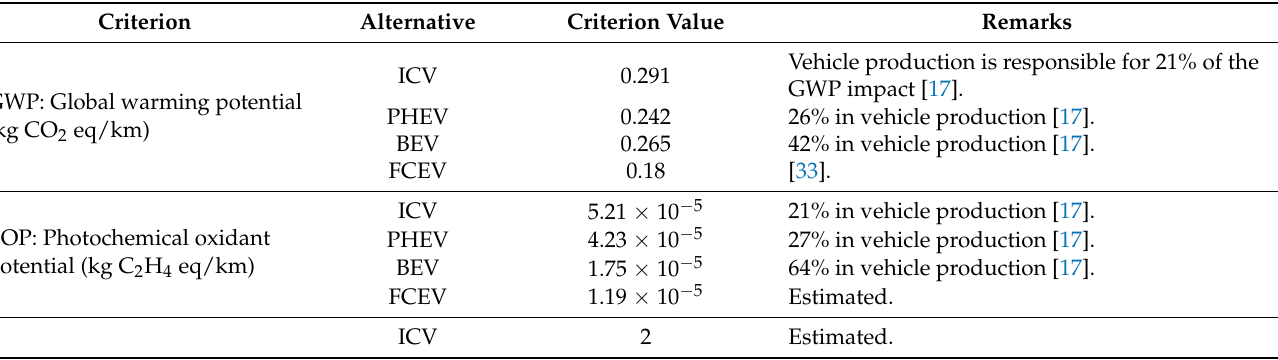
Table 3. Values of each criterion for each